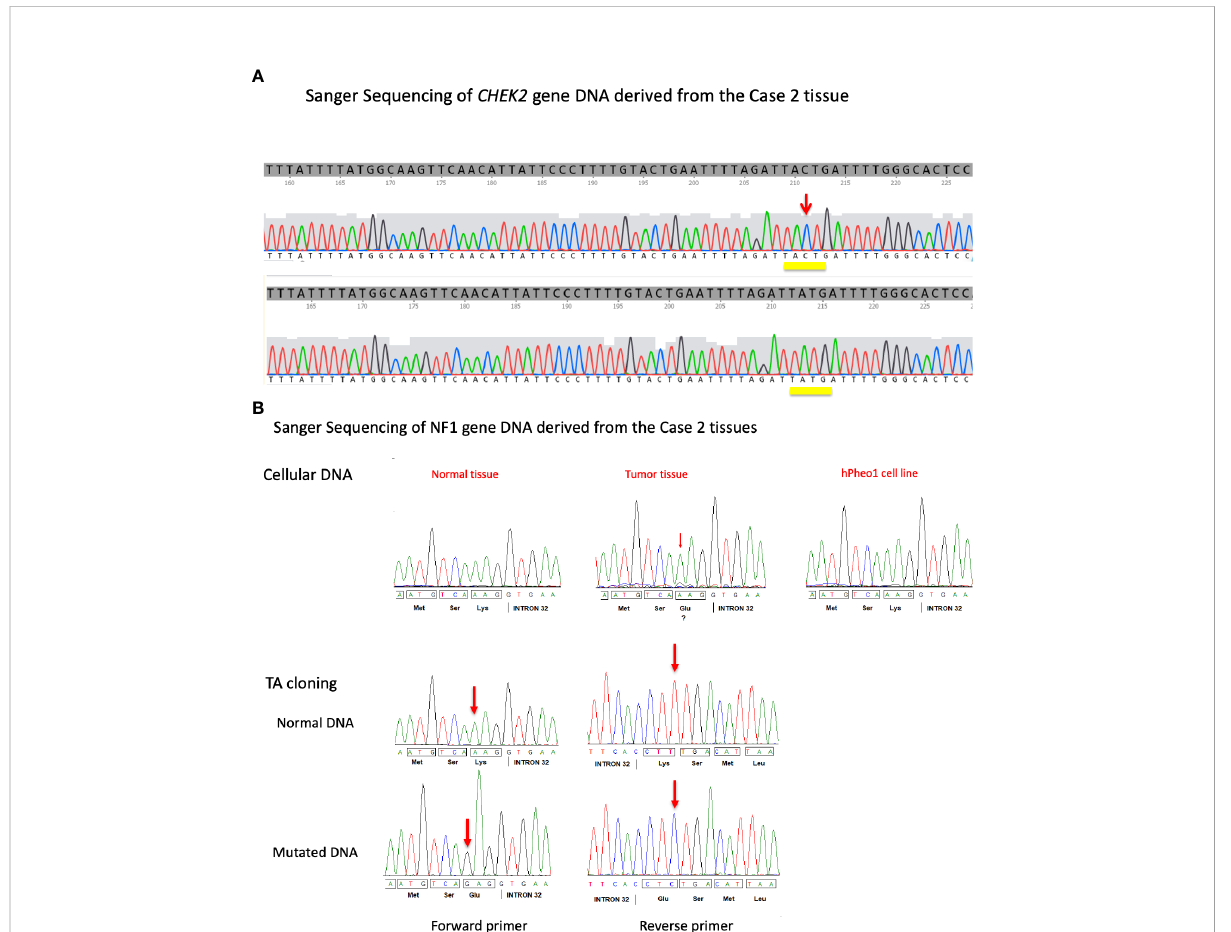
FIGURE 3 (A) DNA sequence traces obtained from the individual clones carrying PCR fragments derived from the hPheo1 cell line derived from the proband ’ s sister ’ s pheochromocytoma tumor. Isolates carrying either a wild-type version ( top ) or the mutant version c.1100delC ( bottom ) of the CHEK2 gene were obtained. The position of the 1100C nucleotide is indicated by a red arrow. (B) Formalin- fi xed paraf fi n-embedded tissue DNA from different slides was ampli fi ed for NF1 exon 32 and sequenced along with hPheo1 DNA ( top ). Additionally, PCR products were TA cloned and isolates sequenced ( bottom ). The position of the mutation is indicated (red